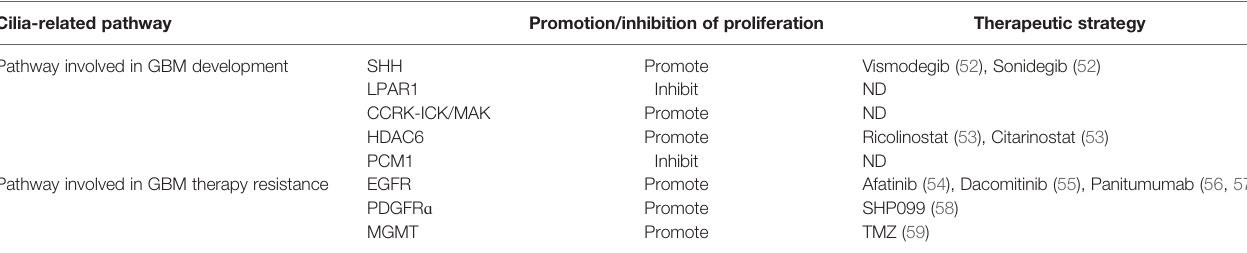
TABLE 1 | Therapeutic strategy and cilia-related pathways associated with glioblastoma development and therapy resistance. Cilia-related